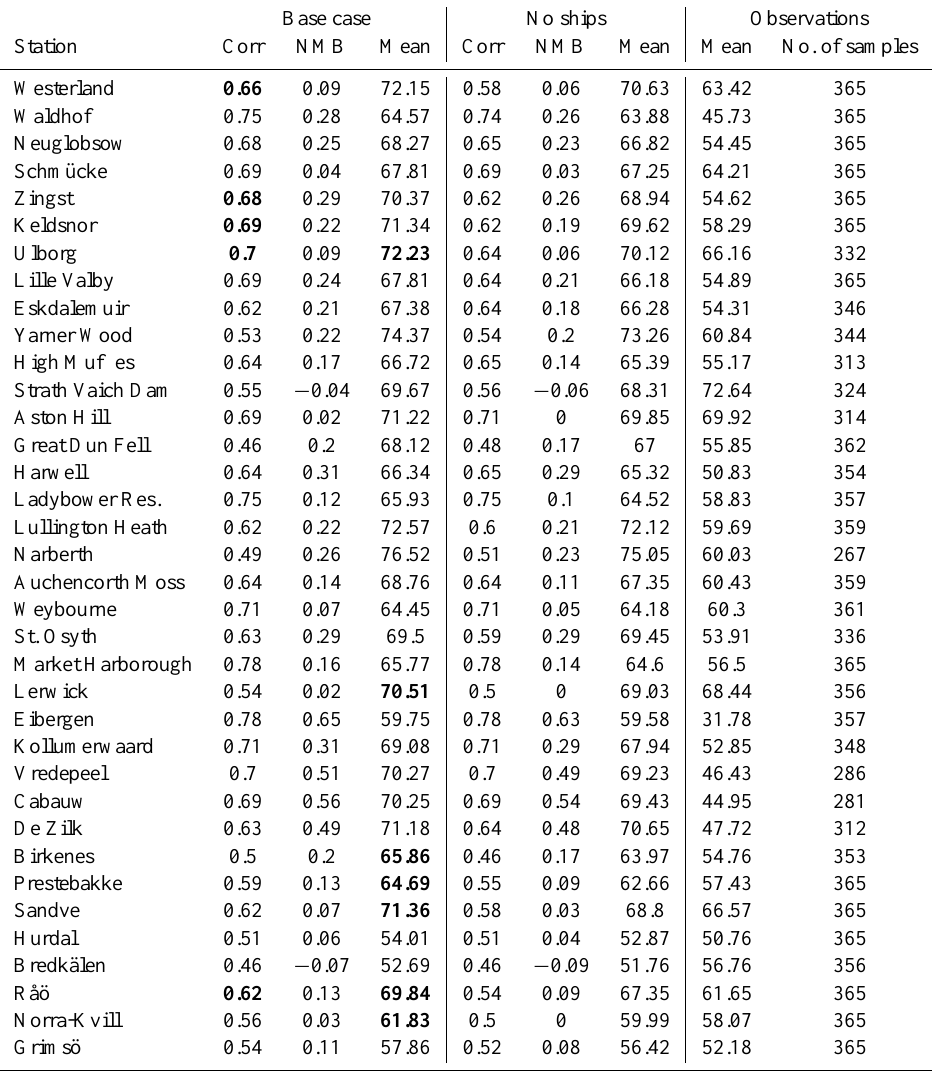
Table 7. Comparison of simulated O 3 concentrations with observations in µgm − 3 . Values that are significantly different between the base case and the no-ships case are printed in bold.